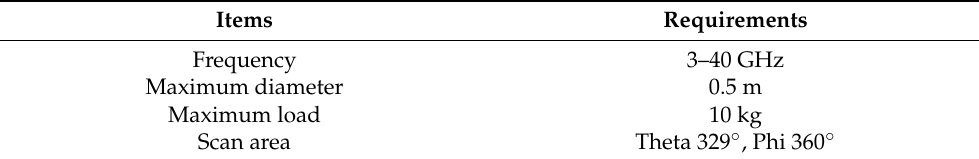
Table 1. Design Specifications.